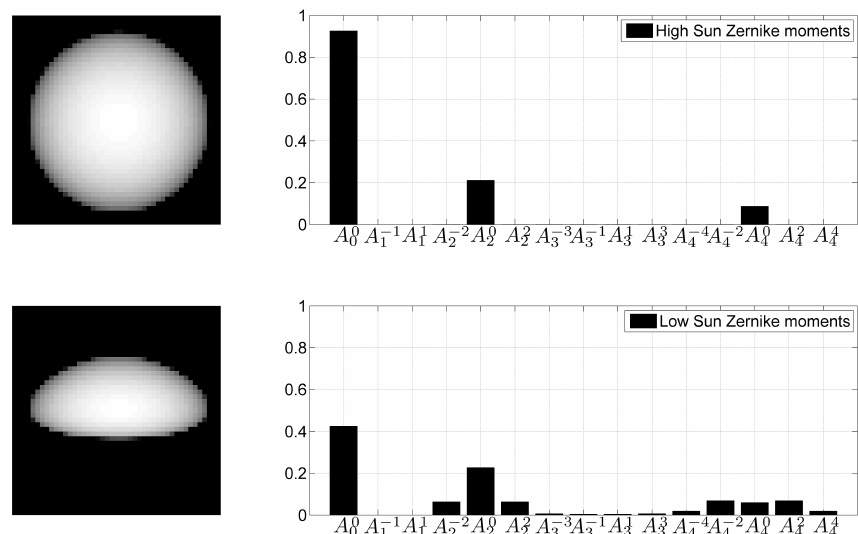
Fig. 4. First 15 Zernike moments computed on a high Sun image and a low Sun image (same as Fig. 2, arbitrary units). In the case of the high Sun image, moments with radial features ( m =0) are the only ones to play a role in characterizing this unrefracted solar disk. For the low Sun, more moments are needed to account for the asymmetrical